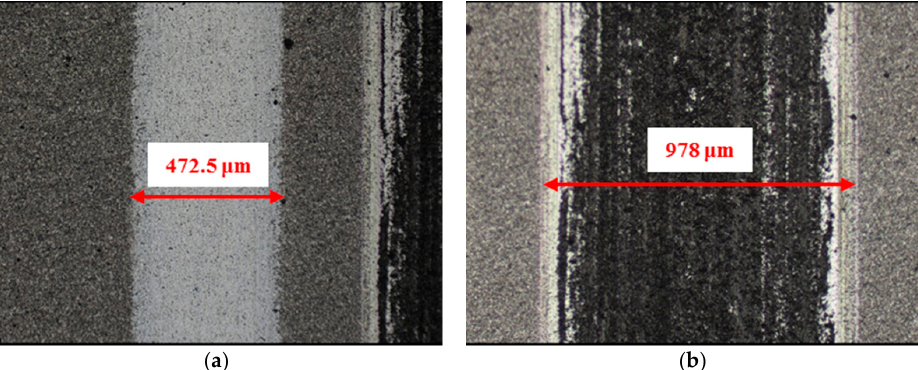
Figure 7. Wear performance of un-textured SiC under dry-friction conditions with a load of 30 N (×10): ( a ) un-textured SiC–steel ball and ( b ) un-textured SiC–Si 3 N 4 ball.